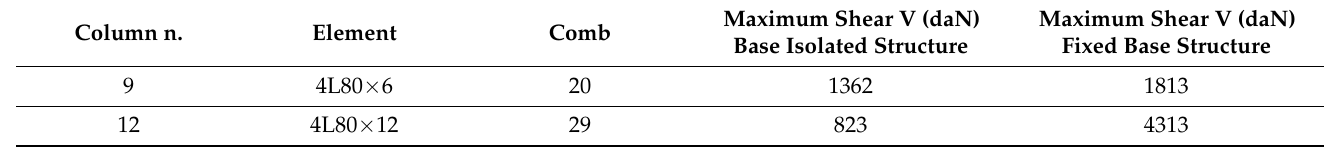
Figure 18. Comparison in terms of shear. ( a ) Base isolated structure. ( b ) Fixed base structure. Table 5. Maximum shear comparison.